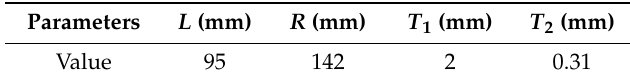
Table 1. Geometrical parameters of the hard-coating cylindrical shell.